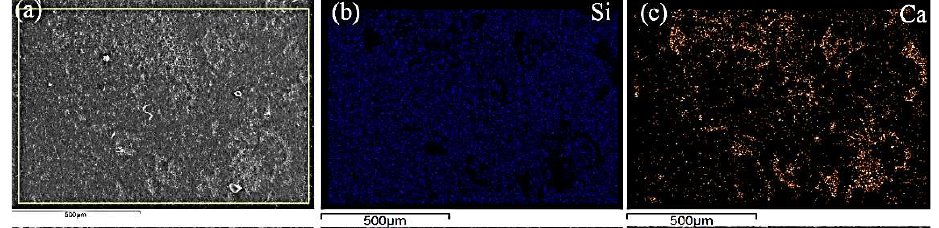
Figure 10. SEM-EDS elemental mapping of sample AVB1 indicating the mode of calcite enrichment.: ( a ) view of the mapping area within the yellow rectangle; ( b ) distribution of Si; ( c ) distribution of Ca.